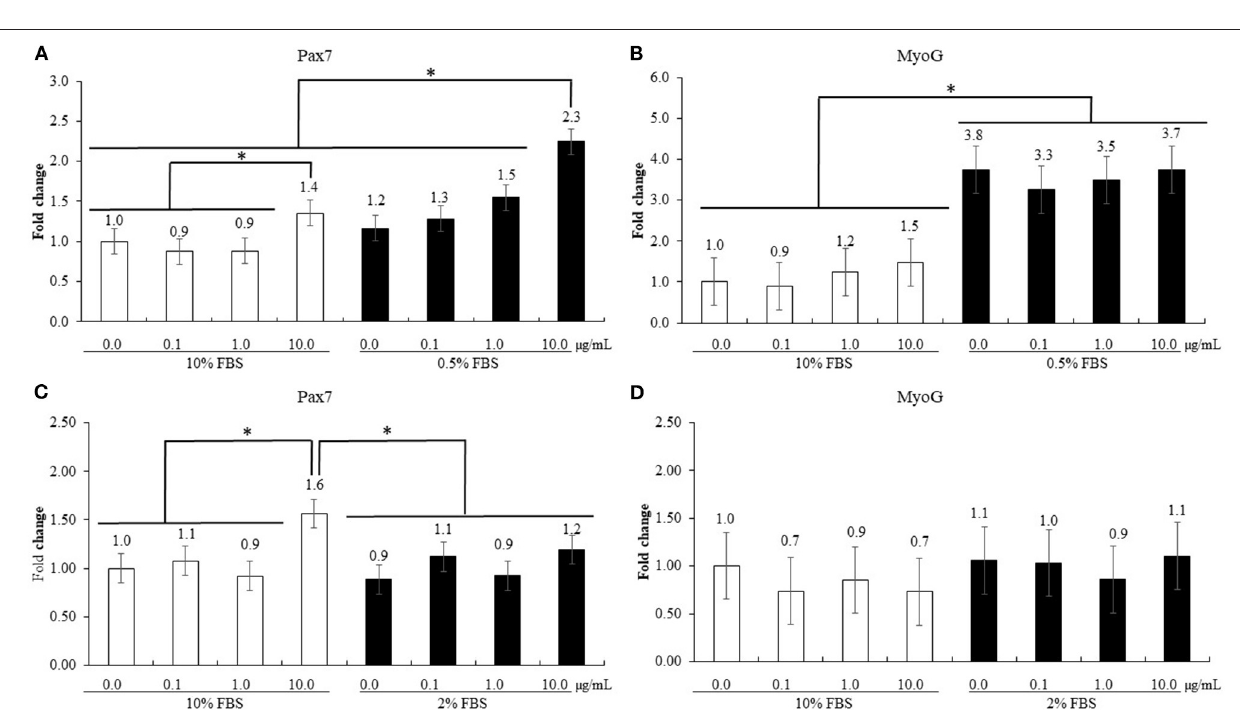
Pro-inflammatory Cytokines In the absence of maltol, infection (NC group) with E. maxima increased ( P < 0.05) the gene expression of TNFSF15 (3.4 × 10 − 3 -2.3 × 10 − 2 ), IL-1 β (1.9 × 10 − 3 -4.9 × 10 − 3 ), and IL-6 (3.0 × 10 − 3 -9.9 × 10 − 3 ) in the distal jejunum compared to that of the CON group ( Figure 8 ). The HI group decreased ( P < 0.05)